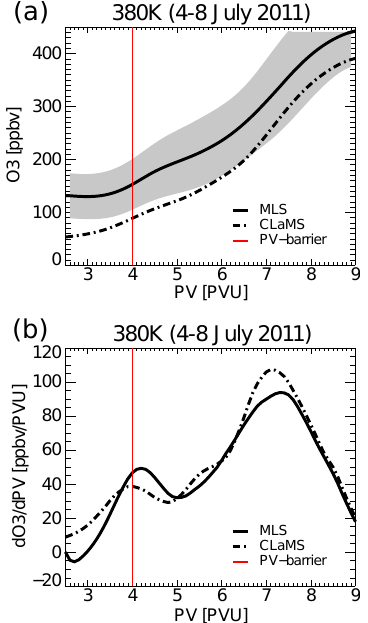
Figure 3. (a) Ozone from MLS (solid) and CLaMS (dashed) vs. po- tential vorticity in the Asian monsoon region (10–60 ◦ N and 10 ◦ W– 160 ◦ E) at 380K, averaged over the period 4–8 June 2011. (b) Same but for the ozone gradient with respect to potential vorticity. Red lines show the transport barrier determined from PV (see